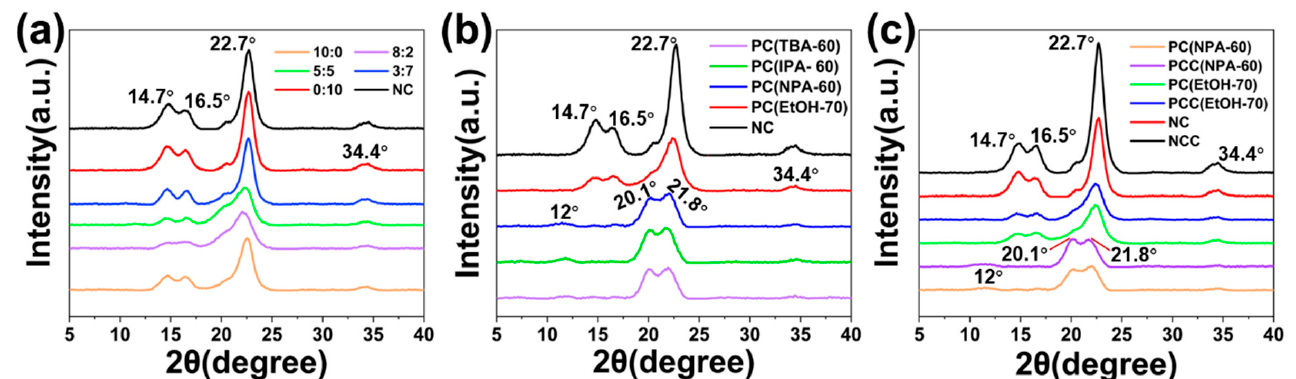
Figure 5. Comparison of XRD patterns of various cotton fibers: ( a ) natural cotton fiber (NC) and various PC(EtOH-100) which are pretreated using an ethanol-water-NaOH system with different V EtOH :V H , where NaOH usage was 100 g/L; ( b ) NC, PC(EtOH-70), PC(NPA-60), PC(IPA-60), and PC(TBA-60), the latter two pretreated fibers are obtained by pretreating with the alcohol-water-NaOH system of isopropanol, and tert -butyl alcohol, respectively, where V alcohol :V H NaOH dosage was 60 g/L; ( c ) NC, PC(EtOH-70), PC(NPA-60), NCC, PCC(EtOH-70), and PCC(NPA- 60).